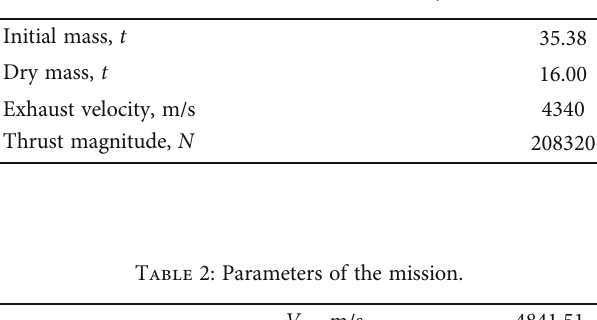
Figure 3: Flight time in LEO updater Table 1: Parameters of the launch system.